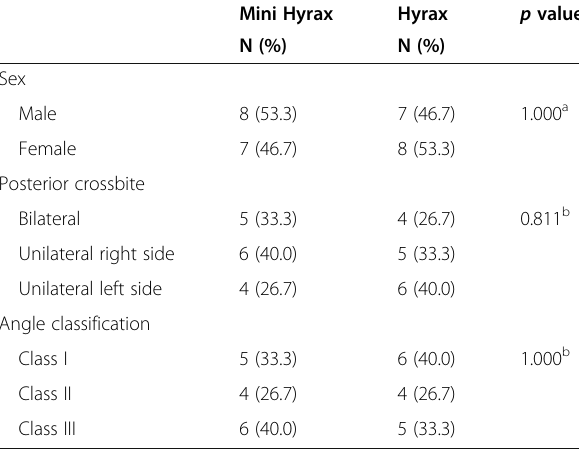
Table 1 Distribution of adolescents regarding sex, posterior crossbite, and angle classification Mini Hyrax